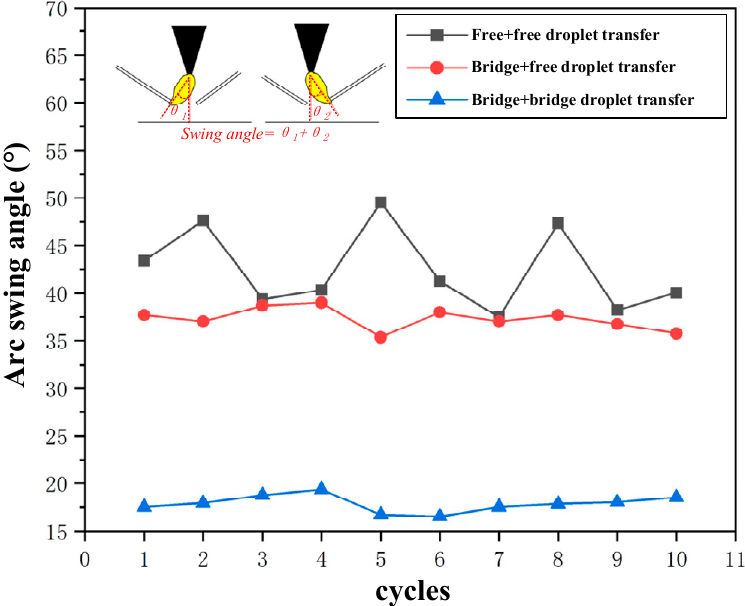
Figure 11. Comparison of the arc swing angles under three droplet transfer modes.